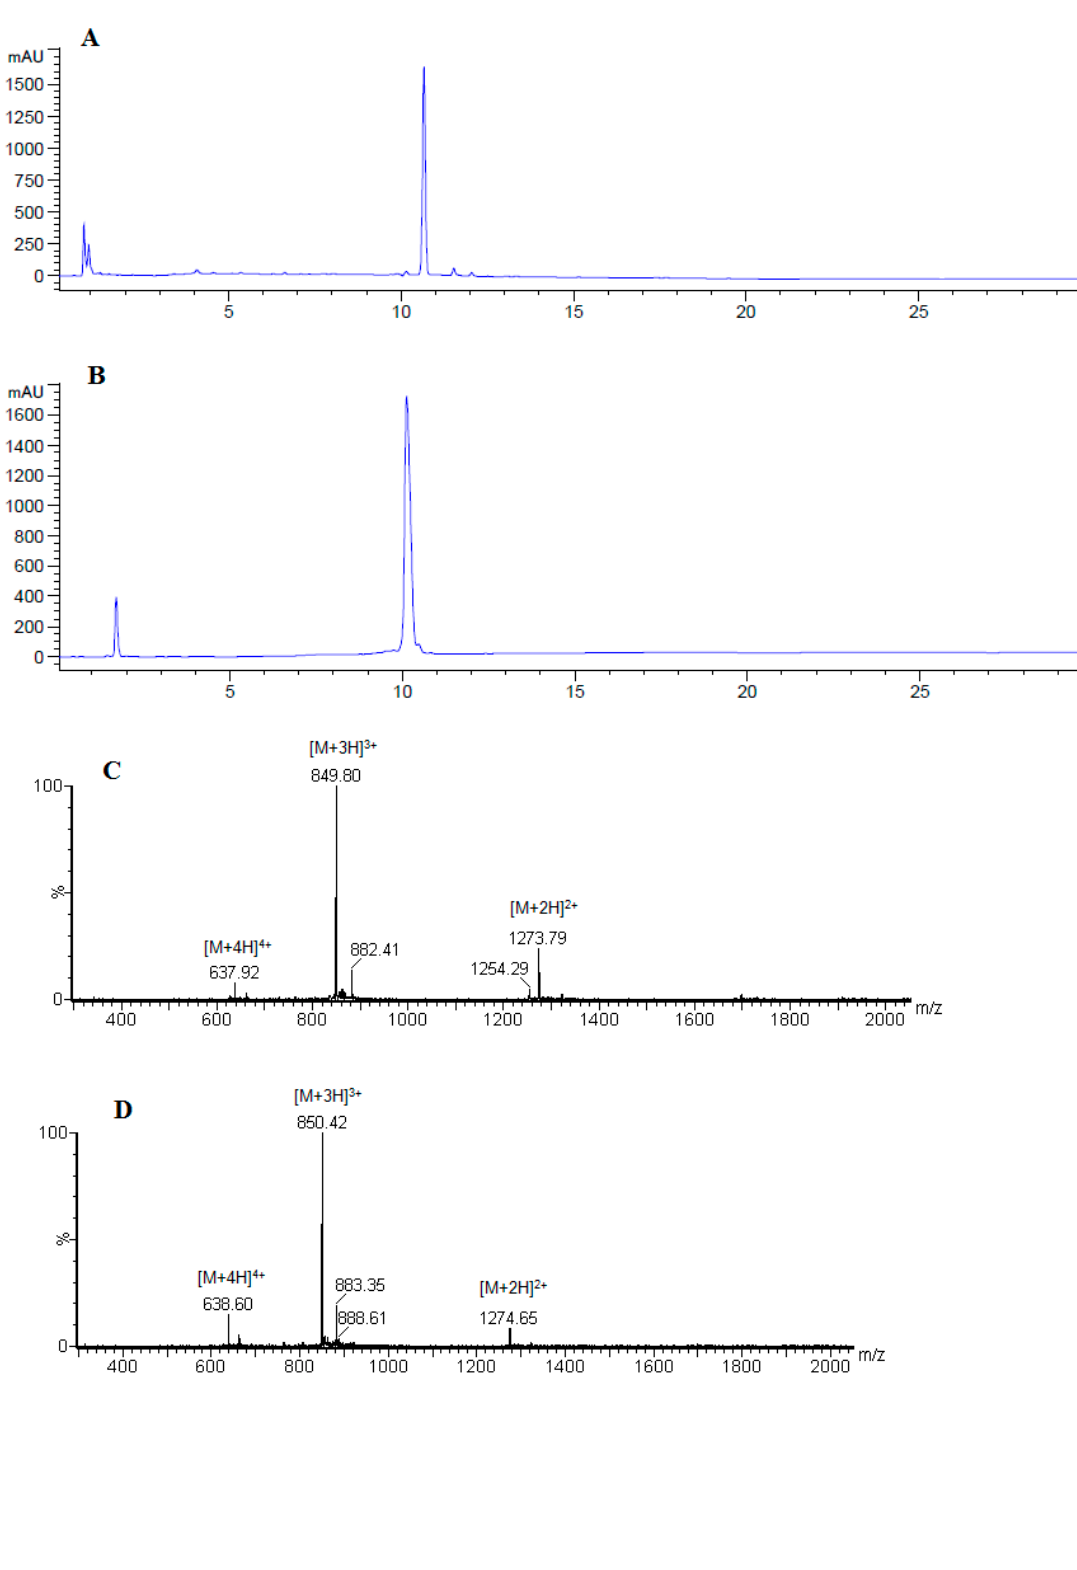
Figure 3. Analytical RP-HPLC of purified cyclo(46–55)MOG 35–55 ( A )